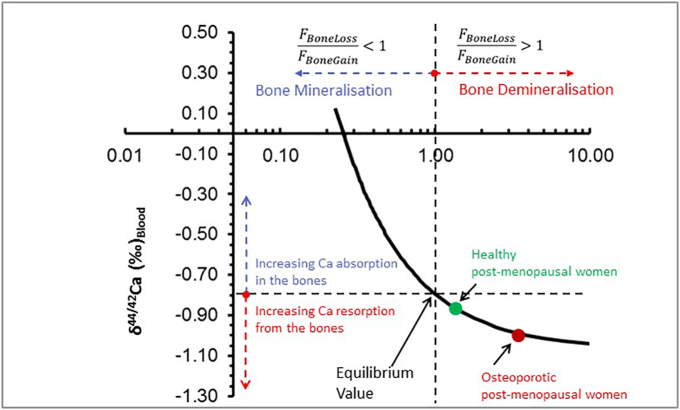
In this diagram the blood Ca isotope values are shown as a function of the FBone-Loss/FBone-Gain ratios. An FBone-Loss/FBone-Gain of 1 corresponds to the equilibrium value at which FBone-Loss equals FBone-Gain. Above the equilibrium value Ca isotope values indicate a net gain of Ca from the blood and below 1 Ca isotopes indicate a net loss of Ca from the bones. The blue point marks the average Ca isotope composition of blood (δ44/42CaBlood) for the healthy post-menopausal women (FBone-Loss/FBone-Gain ~1.3) and the red point marks the average composition of the osteoporotic post-menopausal women (FBone-Loss/FBone-Gain ~3.3). (For interpretation of the references to color in this figure legend, the reader is referred to the web version of this article.)